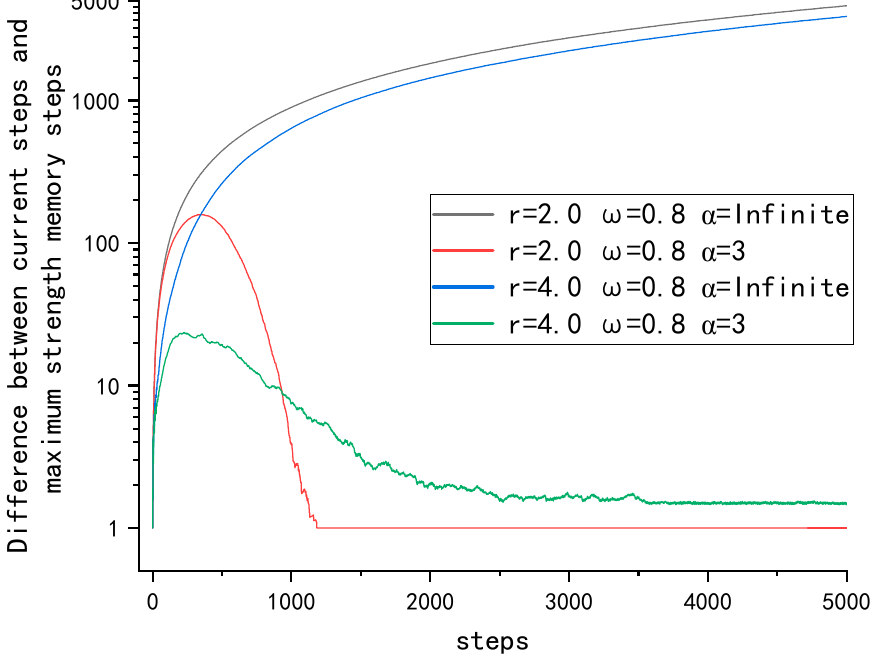
Figure 11. Variation over time of the difference between the current time-step and the timestep where the maximum-intensity memory is located for different combinations of 𝑟 and 𝛼 .